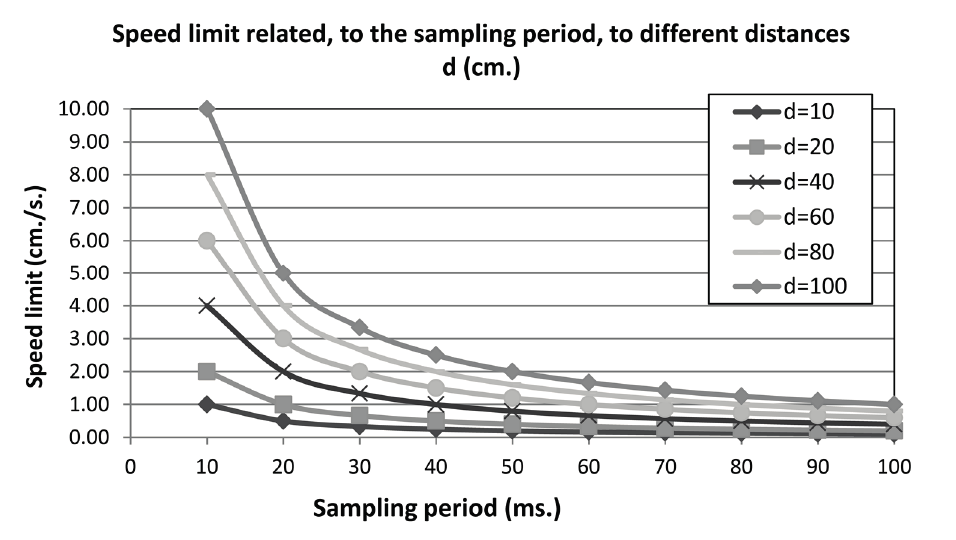
Figure 24. Speed Limit obtained from the distance d and the sample period T.